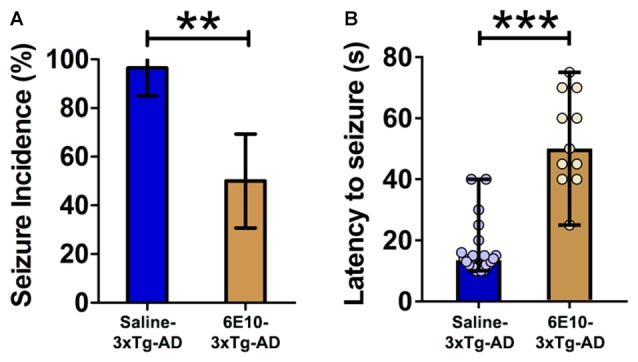
Attenuation of audiogenic seizure susceptibility by passive immunization with anti-human APP/Aβ antibody, 6E10, in 3-week-old 3xTg-AD mice. (A) The incidence of convulsive seizures in 3xTg-AD mice was significantly reduced by passive immunization with 6E10. The data are presented as percent incidence with 95% confidence interval and compared using exact logistic regression stratified by litter. (B) Passive immunization with 6E10 also significantly increased the latency to seizure in 3xTg-AD mice. The data are depicted as median with range, and analyzed using Mann-Whitney U test. **p < 0.01, ***p < 0.001, compared to Saline-3xTg-AD. Saline-3xTg-AD (n = 23) and 6E10–3xTg-AD (n = 22) mice.